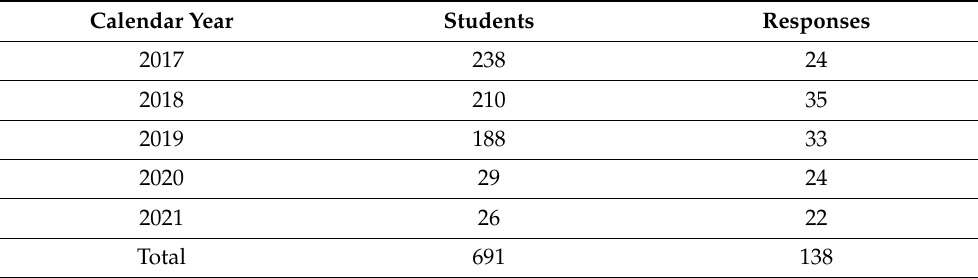
Table 1. Number of student participants that were sent an evaluation and number of responses from 2017–2021.